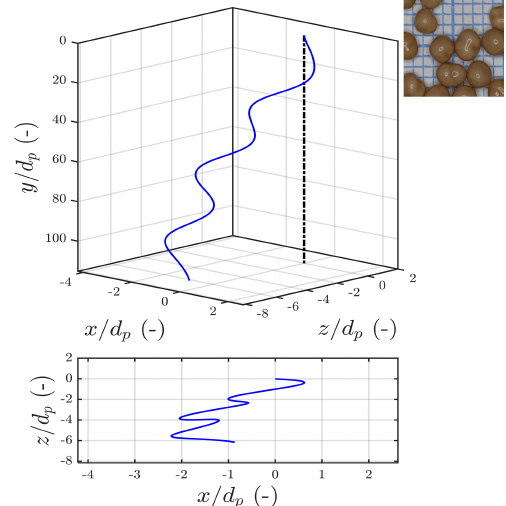
Figure 7. Calcite pellets = 2.36 <d p < 2.8mm, T = 20 ◦ C, C D = 0 . 55, ρ = 2 . 7, Re t = 809, Ga = 522, v t = 0 . 32, v t , BL = 0 . 34, an- gle = 2.8 ◦ , and − % v t = 7%, and path = CH.